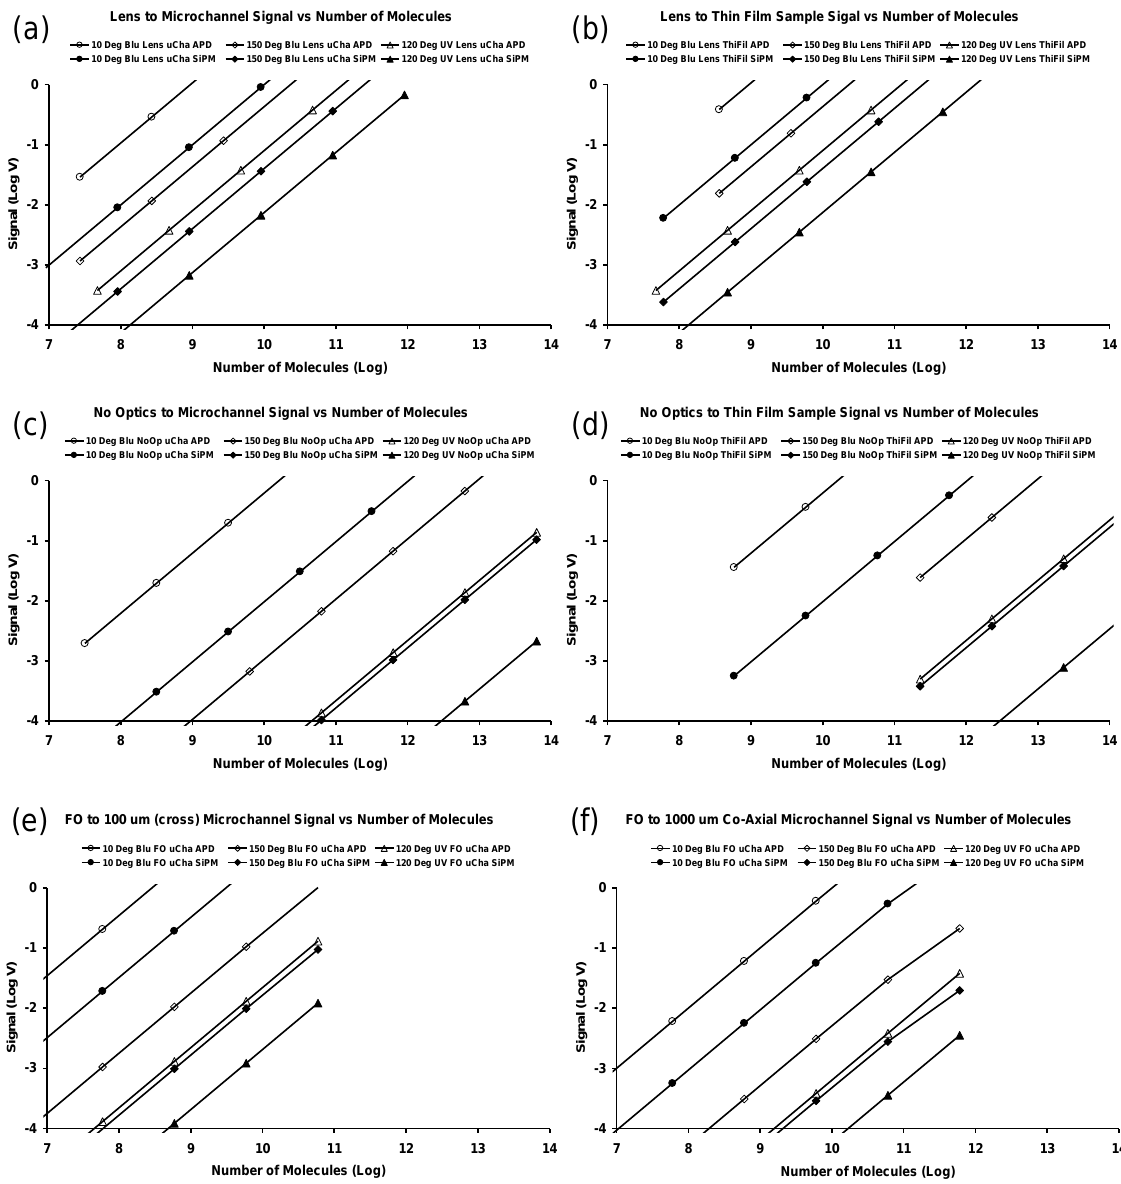
Figure 9. Computed calibration curves as a function of the number of fluorescein molecules for several geometries, sources, optics and detectors. This figure is made by converting the concentration into number of molecules in different volumes shown in Figure 7. Because of the sample volumes are different in various geometrical arrangements, the number of molecules is different at any concentration. Lens to Thin Film Sample Sigal vs Number of